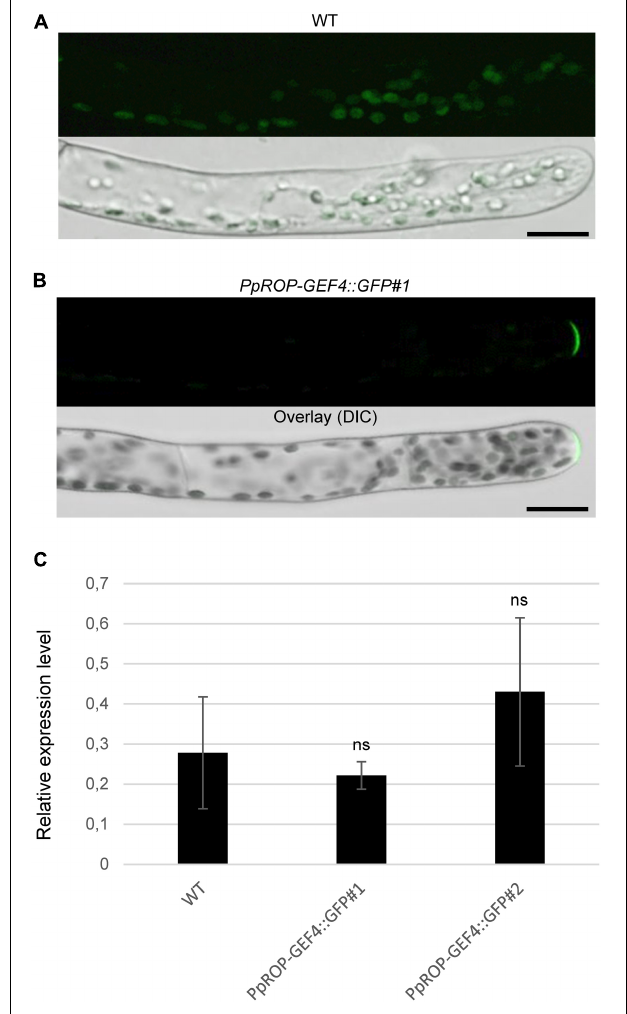
FIGURE 3 | Analysis of the intracellular PpROP-GEF4::GFP distribution in apical cells of PpROP-GEF4::GFP “knock-in” protonemata. (A,B) Medial confocal optical sections through the tips of wild type (WT) (A) or PpROP-GEF4::GFP#1 (B) protonemal filaments (upper panels). Only weak background chlorophyll autofluorescence was visible in WT protonemata ( n = 15). All apical PpROP-GEF4::GFP#1 cells imaged displayed essentially identical PpROP-GEF4::GFP distribution patterns ( n = 20). Overlay (lower panels): the fluorescence images shown in the upper panels overlaid onto transmitted light reference images (differential interference contrast, DIC). Scale bars = 25 µ m. (C) PpROP-GEF4 expression levels in WT and “knock-in” ( PpROP-GEF4::GFP#1 and 2 ) protonemata as determined by qPCR. Relative expression levels are indicated, which represent absolute PpROP-GEF4 transcript levels normalized relative to the absolute transcript level of the reference gene UbC-E2 . The statistical significance of differences